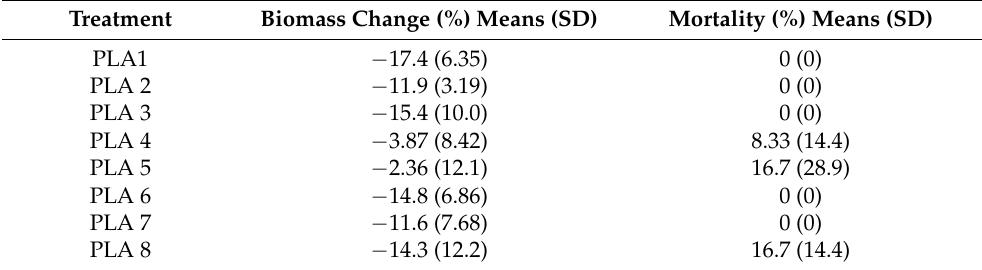
Table 2. Earthworm biomass change (% change of initial biomass/earthworm) and mortality after two weeks of exposure to pla. (mean, sd). No significant differences among treatments according to one way anova, tukey pairwise comparison and dunnett’s treatments-to-control comparisons.